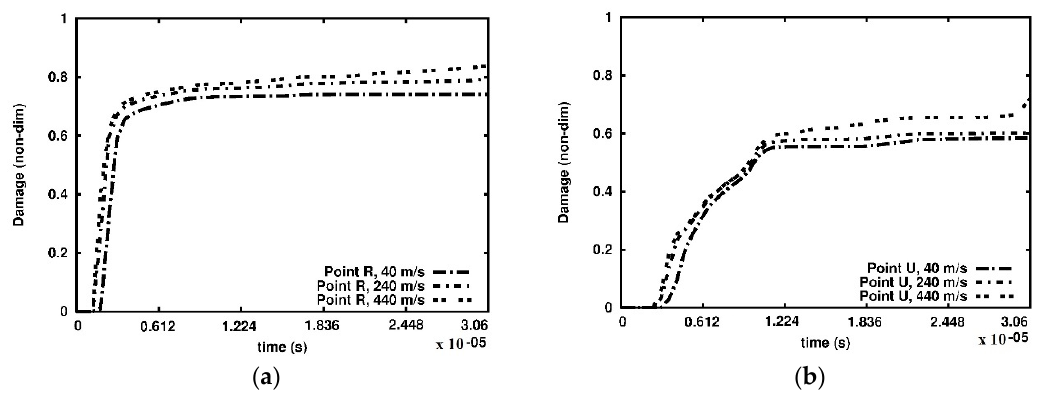
Figure 10. Damage parameter variation, cross-section A-A: ( a ) point R; ( b ) point U.